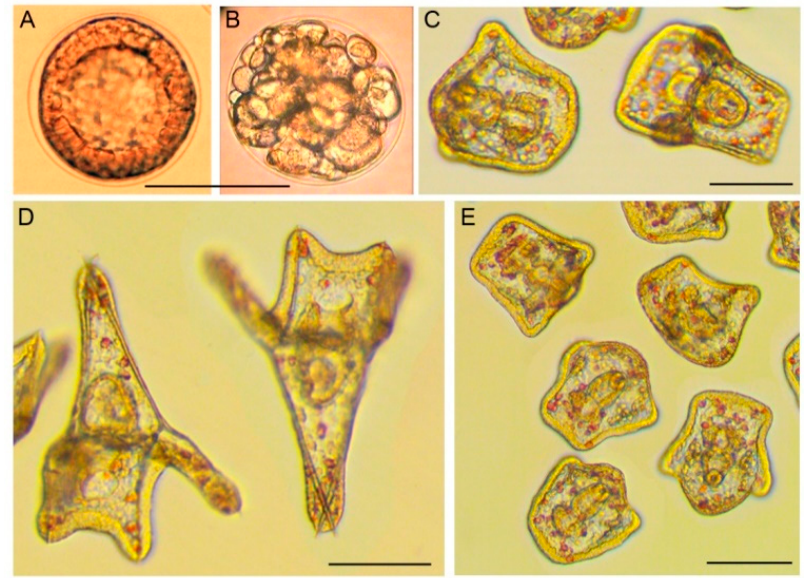
Figure 4. Typical effects of AgNPs and stabilizers on sea urchin embryos, as exemplified by Ag/AMA ( B , E ) and AMA ( C ). Control: ( A ) intact blastula, 5.5 h post-fertilization; ( D ) intact pluteus, 34 h post-fertilization. ( B ) Cleavage disorder caused by Ag/AMA at 1.0/8.0 mg/L exposed to fertilized eggs, 5.5 h post-fertilization. The subsequent embryo death was observed. ( C ) Viable motile retarded plutei (34 h post-fertilization) formed after hatching blastulae treatment by AMA at 4 mg/L, 25 h of exposure, 34 h post-fertilization. ( E ) Viable motile small-size early plutei without skeletal spiculae or with thin short spiculae formed after hatching blastulae treatment by Ag/AMA at 0.25/2 mg/L, 25 h of exposure, 34 h post-fertilization. The embryos in C–E were immobilized with 5-[(6,7-dimethoxy-1,3-benzodioxol-5-yl)methyl]-3-(4-methoxyphenyl)-4,5-hydroisoxazole at a concentration of 2 µM for 20 min [19]. Incubation temperature: 23 °C. Scale bars: 100 µm.